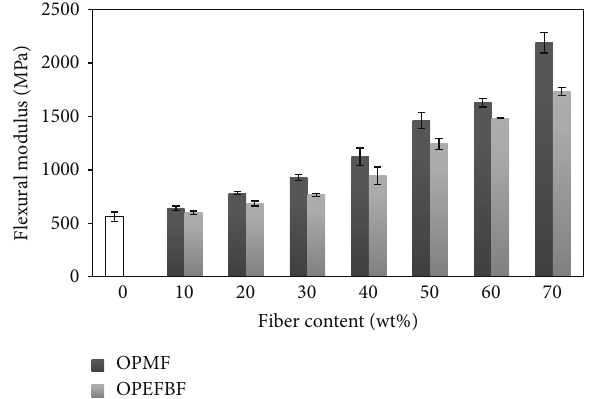
Figure 3: Flexural modulus of PBS, PBS/OPMF, and PBS/OPEFBF biocomposites.